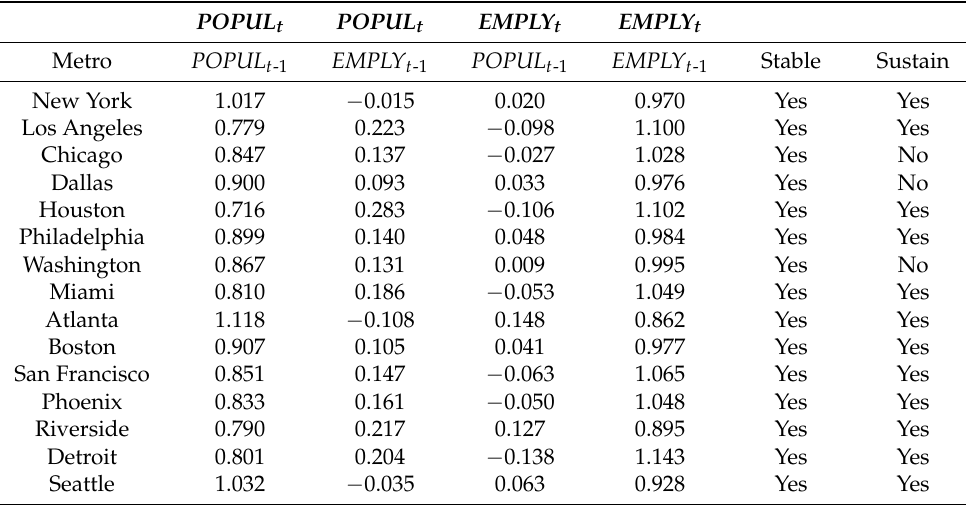
Table 4. Reduced-Form Estimates of Population and Employment: 2000.